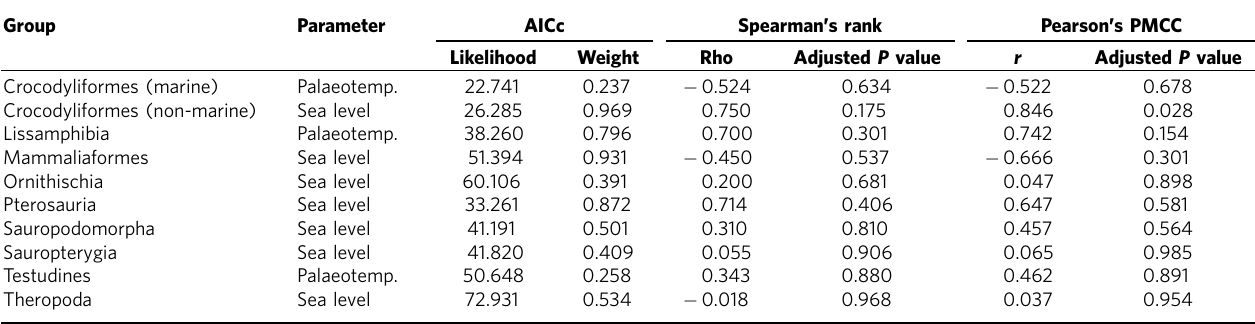
Table 1 | Selected results of model-fitting